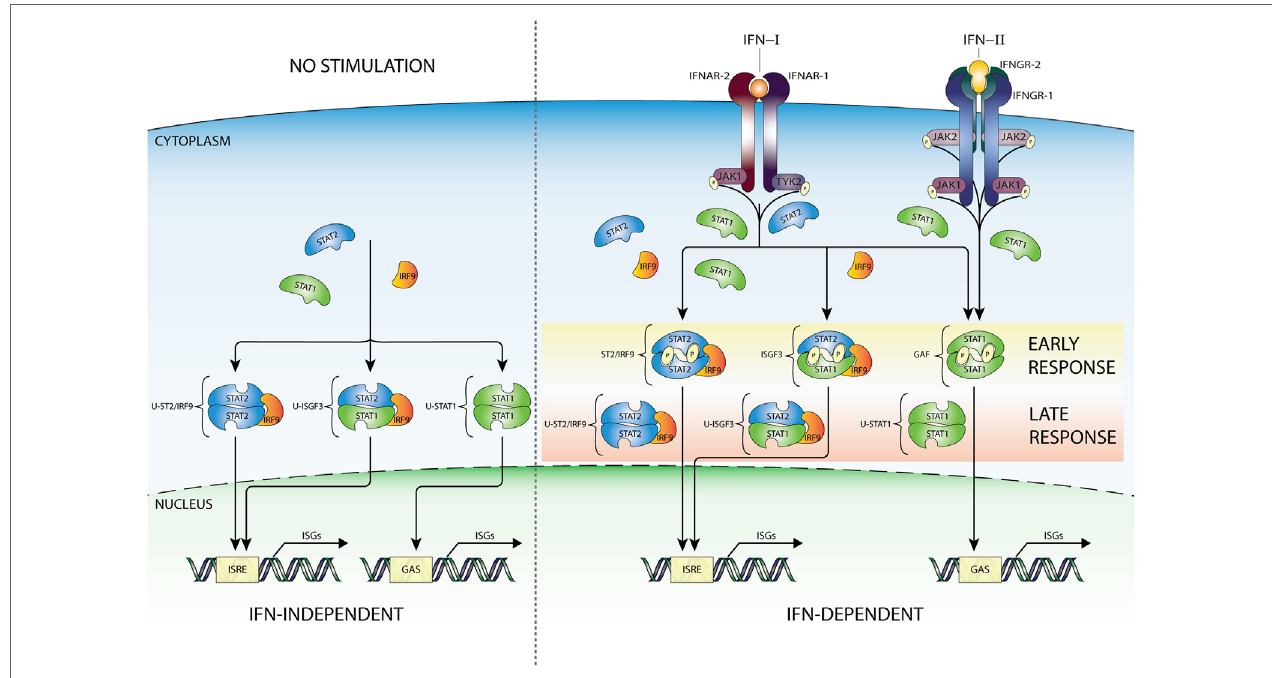
FiGUre 2 | IFN-dependent and -independent ISG transcription mediated by complexes comprised unphosphorylated STATs. In addition to the classical IFN signaling pathway based on complexes of phosphorylated STAT proteins (early response—details Figure 1 ), evidence exists for the involvement of unphosphorylated versions of ISGF3 (U-ISGF3), GAF (U-STAT1), and STAT2/IRF9 (U-STAT2/IRF9), in maintaining basal expression of certain ISGs in unstimulated cells (IFN independent). In addition, these unphosphorylated complexes are instrumental in sustaining expression of ISGs in response to long-term IFN-I or IFN-II stimulation (IFN dependent), when the level of phosphorylated STAT proteins is decreasing, but de novo synthesized unphosphorylated STAT proteins accumulate and can be incorporated in unphosphorylated transcription factors (late response). Abbreviations: IFN, interferon; STAT, signal transducer and activator of transcription; IRF, interferon regulatory factor; JAK, Janus kinase; TYK, tyrosine kinase; ISGF3, interferon-stimulated gene factor 3; GAF, γ -activated factor; ISRE, interferon-stimulated response element; GAS, γ -activated sequence; ISG, interferon-stimulated gene; P, phosphate; U, unphosphorylated